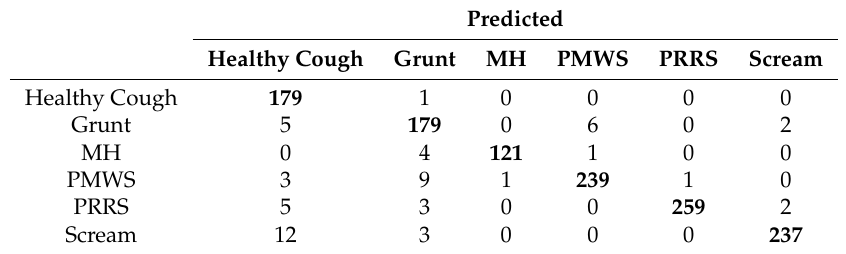
Table 6. Confusion matrix for identification of pig abnormalities (Test: Clean + All synthesized noise